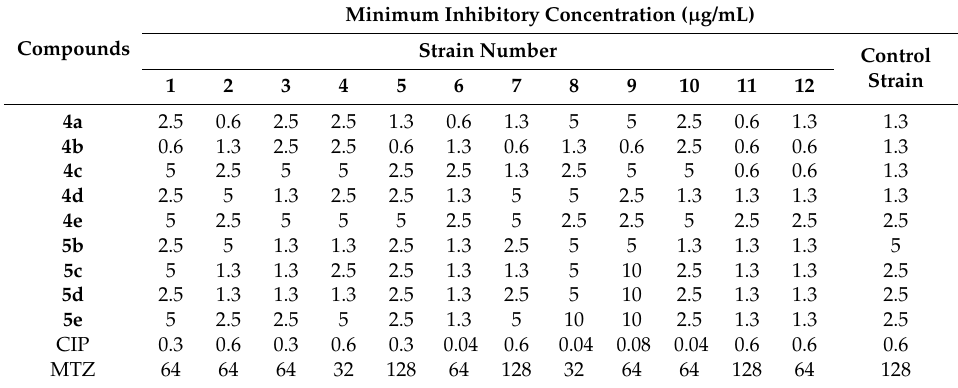
Table 2. Minimum inhibitory concentration (MIC, µ g/mL) of tested compounds and metronidazole against clinical strains of H. pylori (1–12) and control strain by two-fold agar dilution method. Minimum Inhibitory Concentration ( µ g/mL) Compounds Strain Number Control